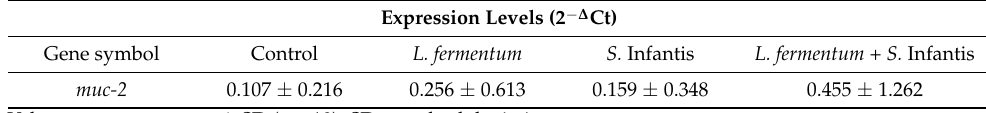
Values represent means ± SD ( n = 10). SD: standard deviation.